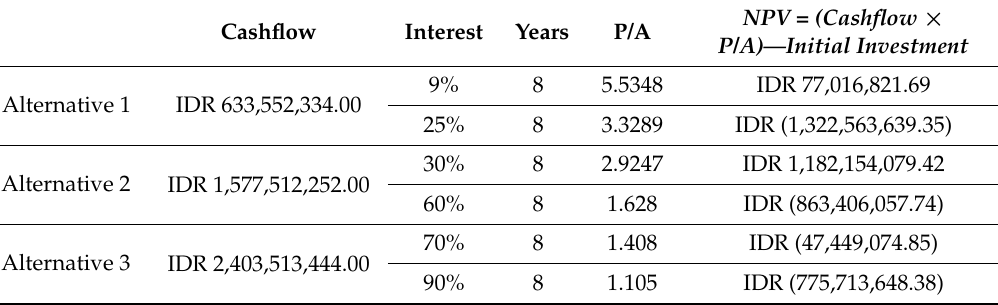
Table 8. Calculation for NPV Values.